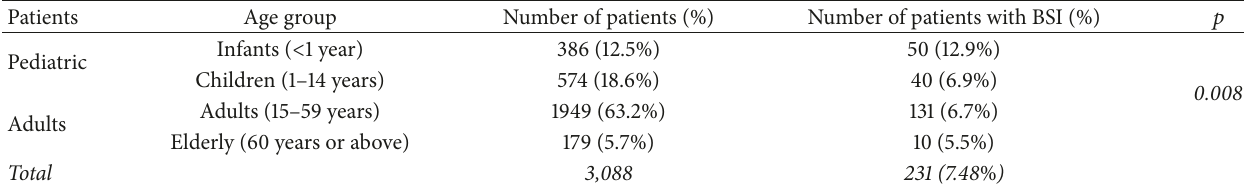
Table 1: Trends of bloodstream infection among various group of patients ( 𝑛 =